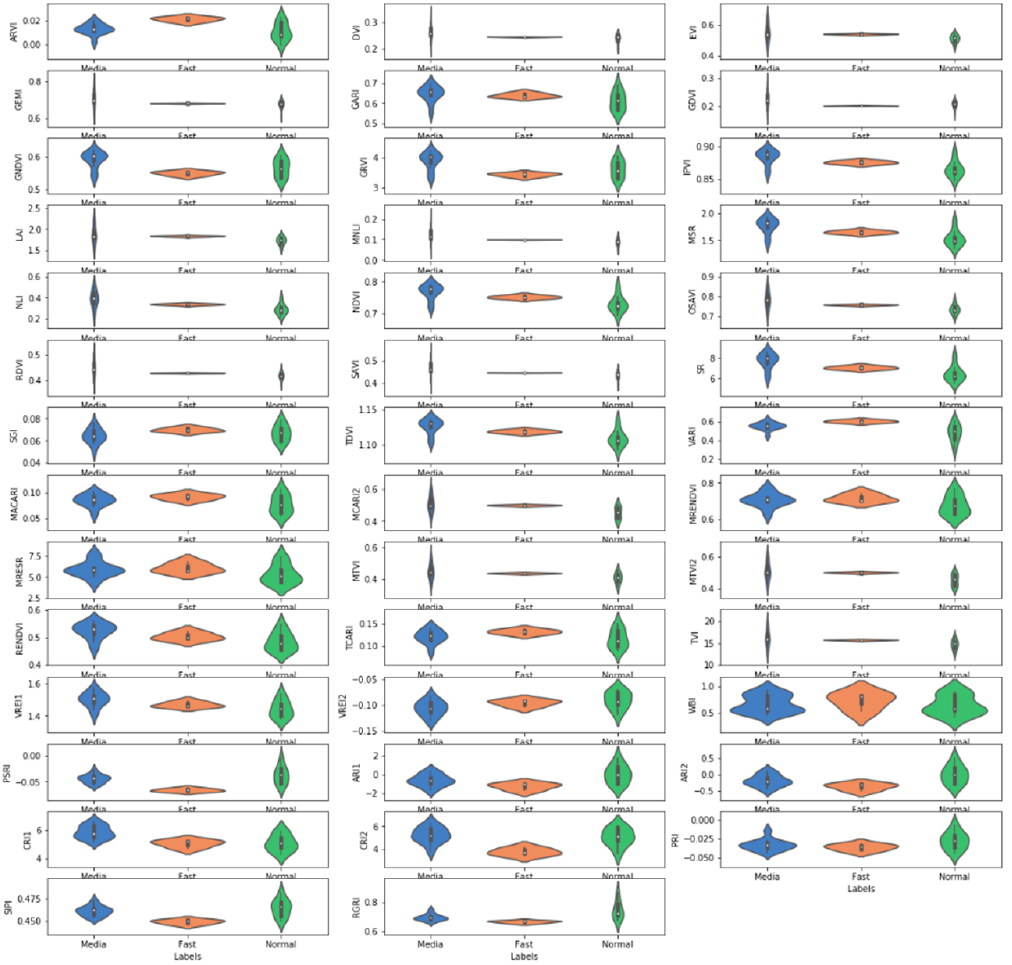
Figure 2. Data distribution of 41 vegetation indices of three clusters. Each column represents the data distribution of the represented group, the mean was represented by the white spot inside the column.